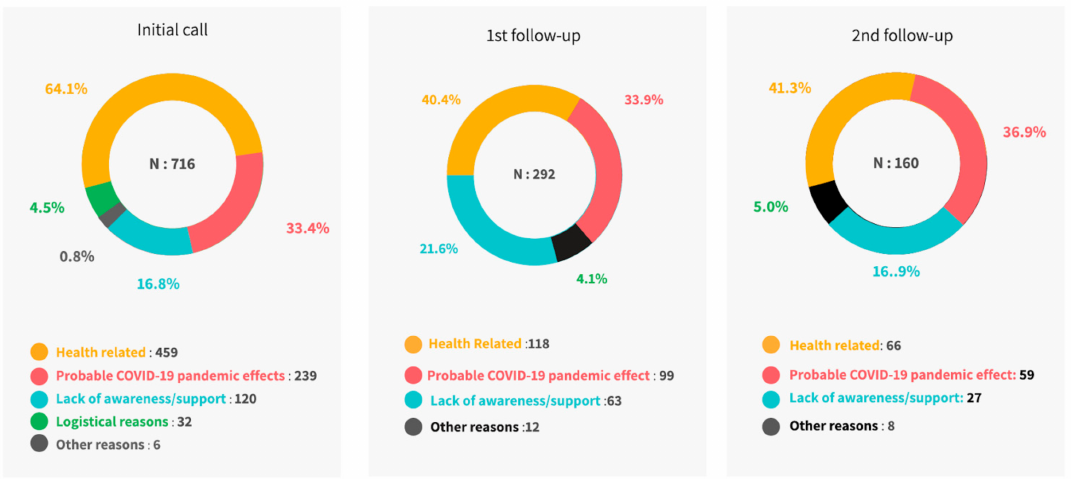
Figure 2. Overall reasons for